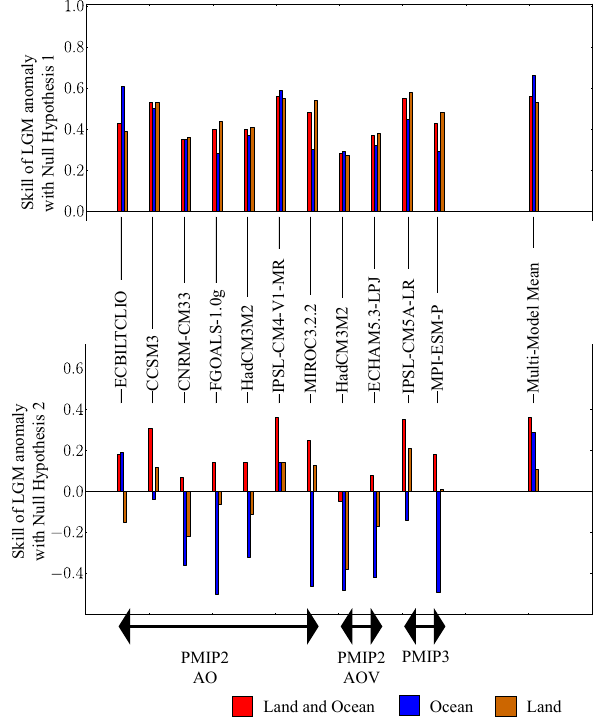
Fig. 5. Skill for the LGM anomaly. The top plot shows the result us- ing the first reference that the LGM anomaly is zero, and the lower plot the results using the second reference that the LGM anomaly is equal to the data